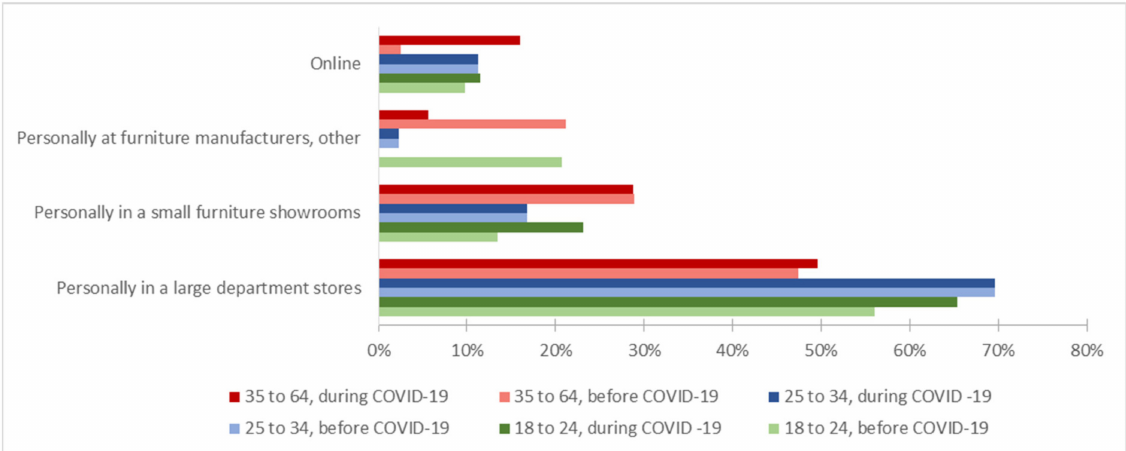
Figure 11. Comparison of the places for furniture purchasing regarding the age category before ( N = 400) and during the COVID-19 time ( N =